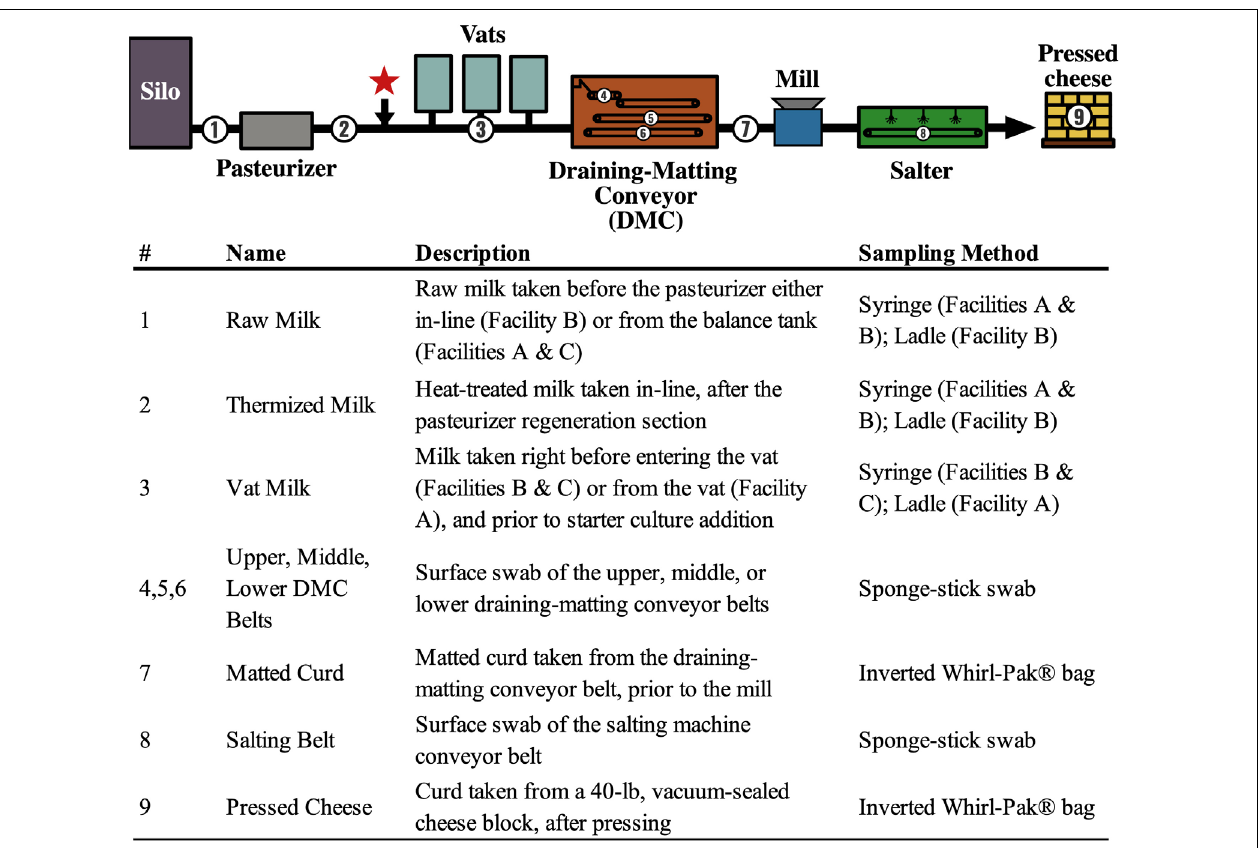
FIGURE 1 | Flow diagram showing the generic Cheddar cheesemaking process and sample collection points. Numbers denote sampling locations within the cheese production facilities (A, B, C). Descriptions of each sample location and the method used are listed. The red star indicates the approximate location of starter addition. Thermization conditions used at each facility are 67–70 ◦ C for